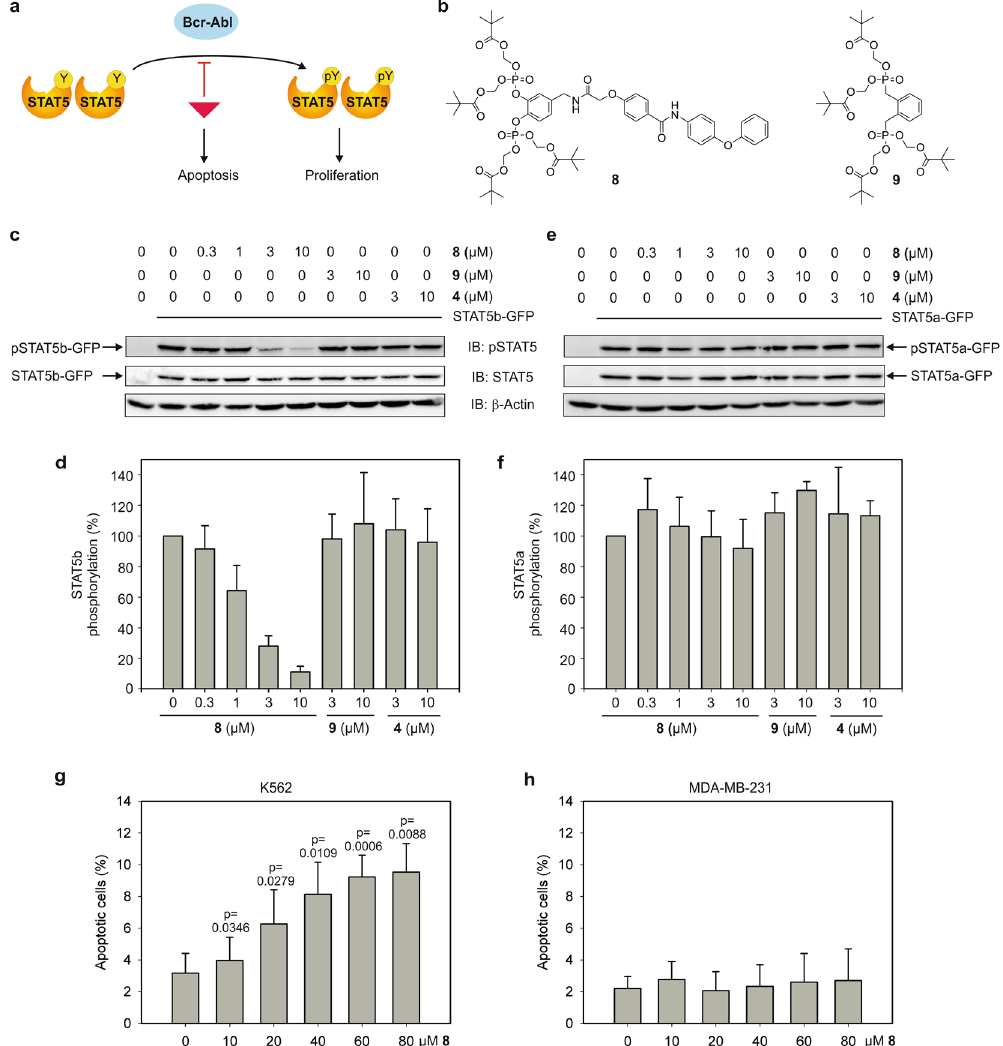
Figure 3. Pomstafib-2 ( 8 ) inhibits STAT5b signalling with high activity and selectivity in K562 leukaemia cells. ( a ) Expression of Bcr-Abl results in constitutive activation of STAT5. Inhibition of signalling via STAT5 leads to apoptosis. ( b ) Structures of pivaloyloxymethylesters 8 and 9 15 . ( c ) Dose-dependent inhibition of STAT5b phosphorylation in STAT5b-GFP-transfected K562 cells by 8 . Cropped blots are displayed; full- length blots are presented in Supplementary Fig. S9. ( d ) Quantitation of the data shown in c) from 2–4 independent experiments, with phospho-STAT5b-GFP levels normalized against total STAT5b-GFP. Error bars represent standard deviations (s.d.). ( e ) Phosphorylation of STAT5a in STAT5a-GFP-transfected K562 cells is not inhibited by 8 . Cropped blots are displayed; full-length blots are presented in Supplementary Fig. S9. ( f ) Quantitation of the data shown in ( e ) from 2–4 independent experiments, with phospho-STAT5a-GFP levels normalized against total STAT5a-GFP. Error bars represent standard deviations (s.d.). ( g ) 8 induces a dose-dependent increase in the apoptotic rate of STAT5-dependent K562 cells. Error bars represent standard deviations (n = 3). Numbers on top of the bars indicate the p-values (t-test, two-tailed, paired). ( h ) 8 does not increase the apoptotic rate of STAT5-independent MDA-MB-231 cells (n =